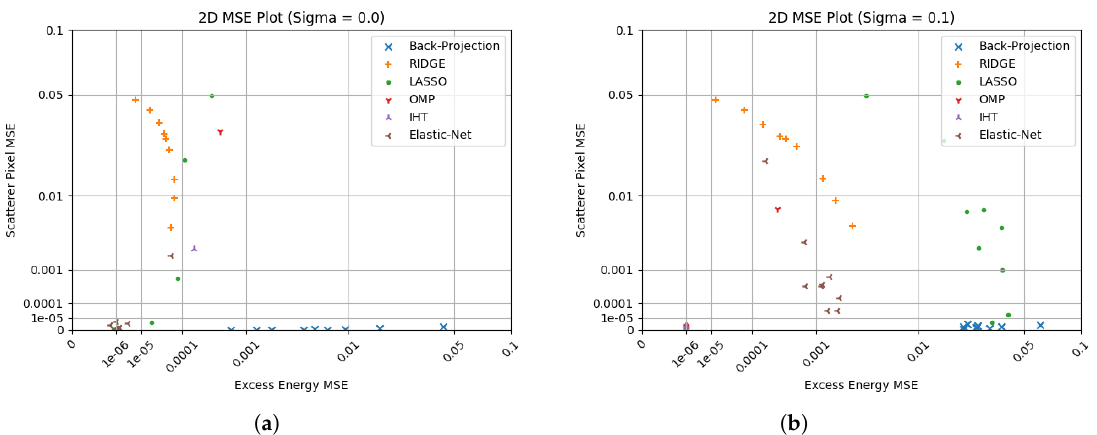
Figure 8. Analysis of 5 algorithms compared to back-projection via logarithmic 2D plotting. Note that any exactly 0 values have been defaulted to 1 × 10 − 5 to assist log plotting. ( a ) 2D scatterer vs. excess energy plot without noise; ( b ) 2D scatterer vs. excess energy plot including noise ( σ =